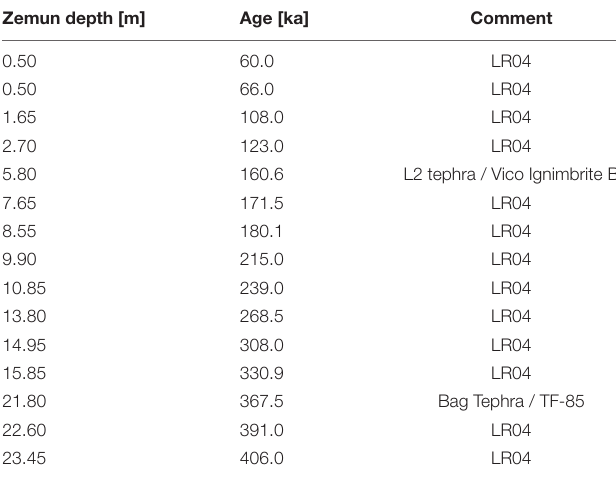
TABLE 1 | Selected tiepoints for age model